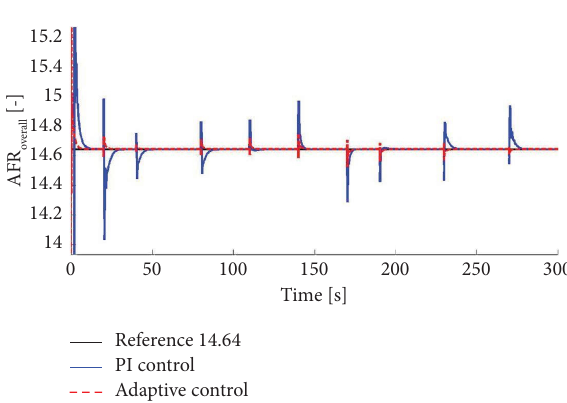
Figure 8: Fuel mass fow rate.